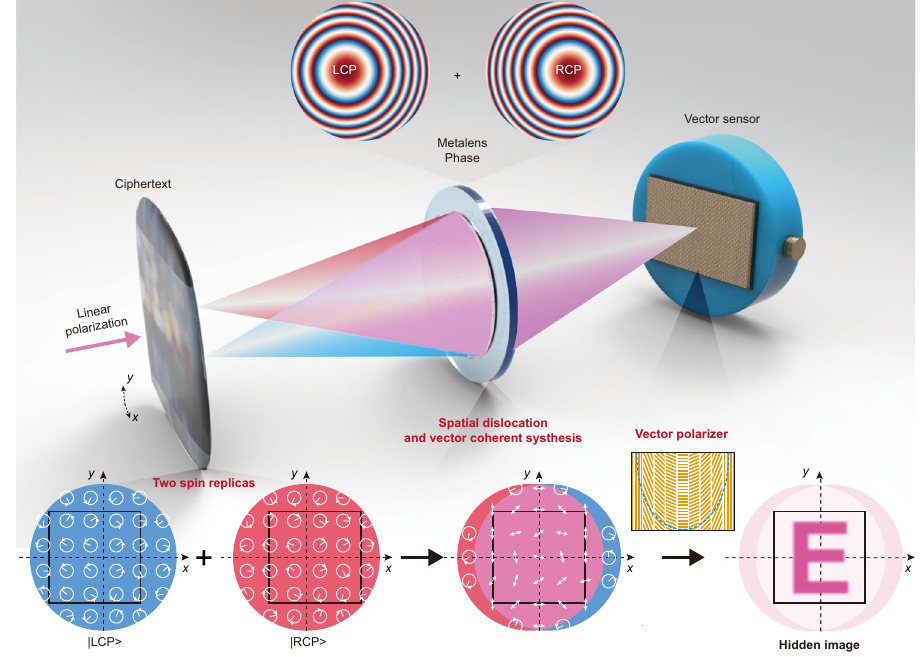
Fig. 1 | Schematics of a meta-optics-empowered decryption camera for vector VC. Thedecryptioncameraiscomposedofspin-decoupleddual-axismetalens(the phase pro fi le is schematically shown in the top panel) and a vector polarization- analyzer sensor (indicated in the inset). The spin-decoupled dual-axis metalens divides the coded phase-type ciphertexts into two replicas with opposite circular polarized states and projects them to the image plane with spatial dislocation and